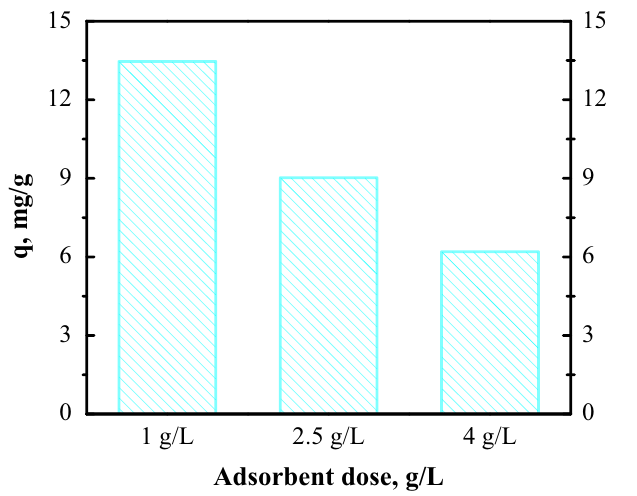
Figure 8. Congo Red dye adsorption vs. fly ash